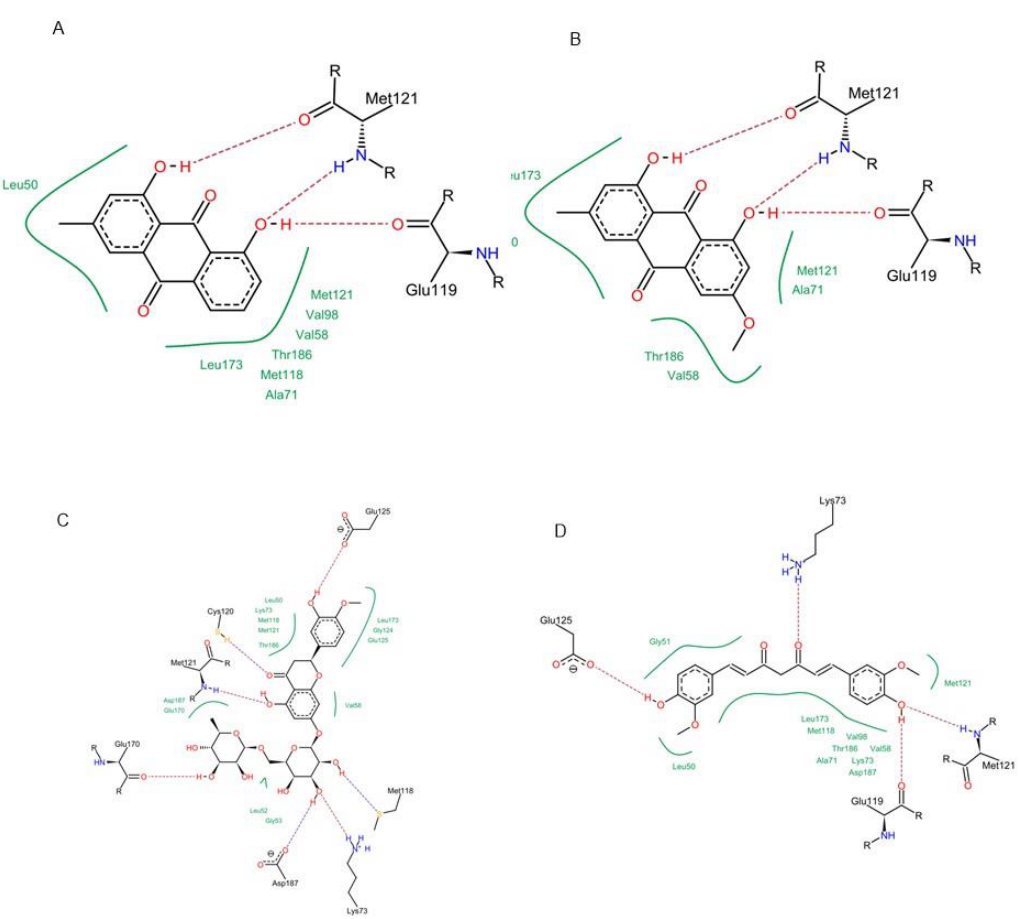
Figure 13. 2D Protein-ligand binding interaction diagram of chrysophanol ( A ), physcion ( B ), hesperidin ( C ) and Curcumin ( D ) with MK-3 MAPK (PDB ID: 3SHE).